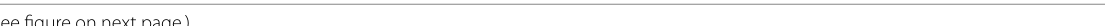
liver(See figure on next Fig. 12 Diagnosis: Ewing sarcoma. Technique: standard chest radiography and contrast-enhanced chest CT. Description: A 23-year-old man was referred for a chest radiograph due to pain at the right hemithorax. The postero-anterior chest radiographs ( a , b ) show an opacity (arrow) projecting at the level of the 7th right rib. An external radio-opaque marker was placed on the painful area. The additional contrast-enhanced CT further characterizes the mass encasing the 7th right rib with a locoregional aggressive periosteal sunburst type reaction and a surrounding soft tissue component ( c , d ). On the axial T1-weighted MR image ( e ) the lesion has an isointense signal to muscle and a high signal intensity on the axial FS T2-WI ( f ) with invasion of the muscles of the chest wall (arrows). After intravenous contrast administration, the lesions show a heterogeneous enhancement ( g ), predominantly at the periphery of the lesion. The coronal T2-weighted MR image ( h ) shows the extrinsic impression of the lesion on the